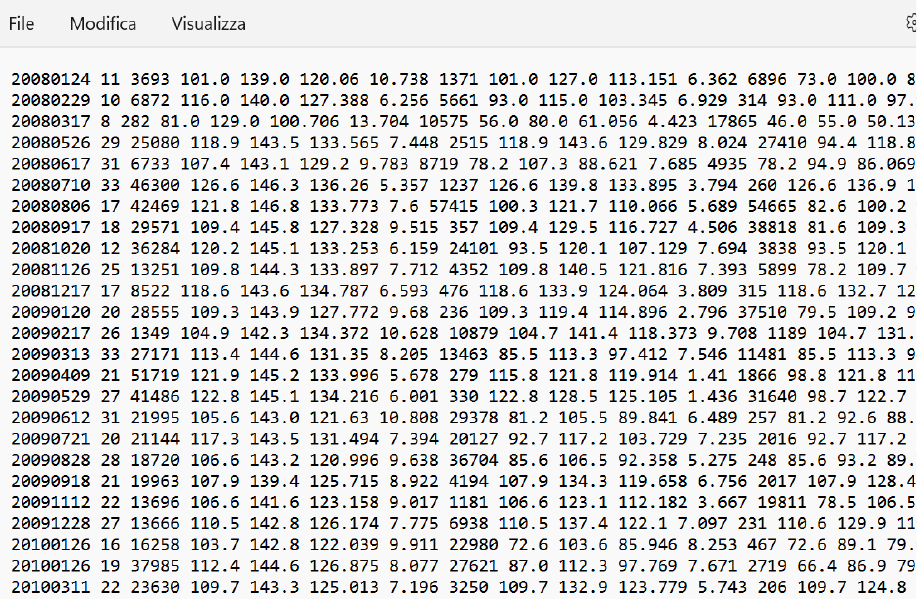
Figure 10. Thermal image example taken in La Solfatara crater (Campi Flegrei), indicated as “Sf3a” in Figure 1.